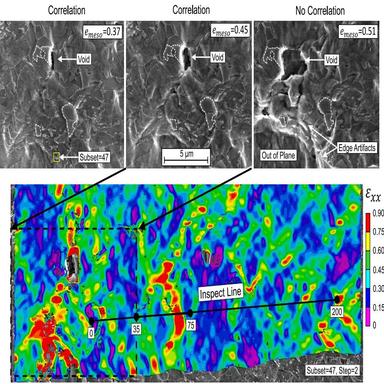
The last three SEM micrographs from the in-situ DP980GI test and the μDIC contours of true strain in the x-direction (εxx) for the middle deformation state.